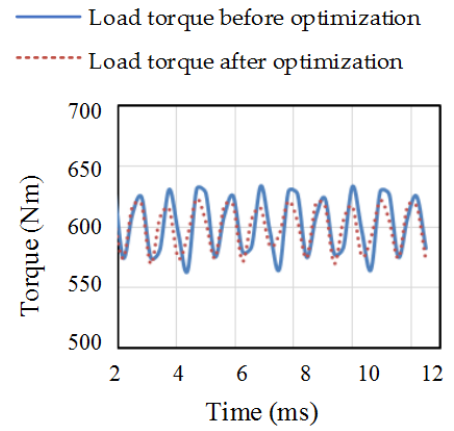
Figure 12. Torque of the AFPMSM at the peak load.